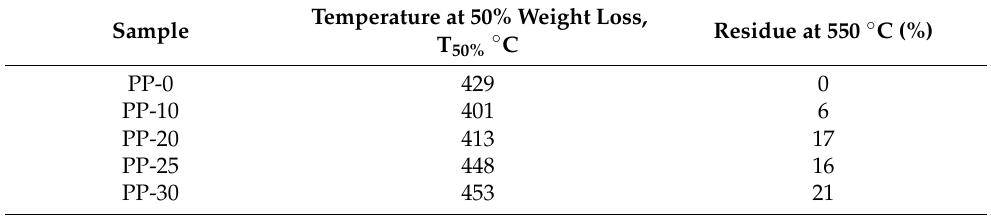
Table 2. Temperature at 50% weight loss and residue at 550 ◦ C of the PP/TiO 2 /lignin composites.